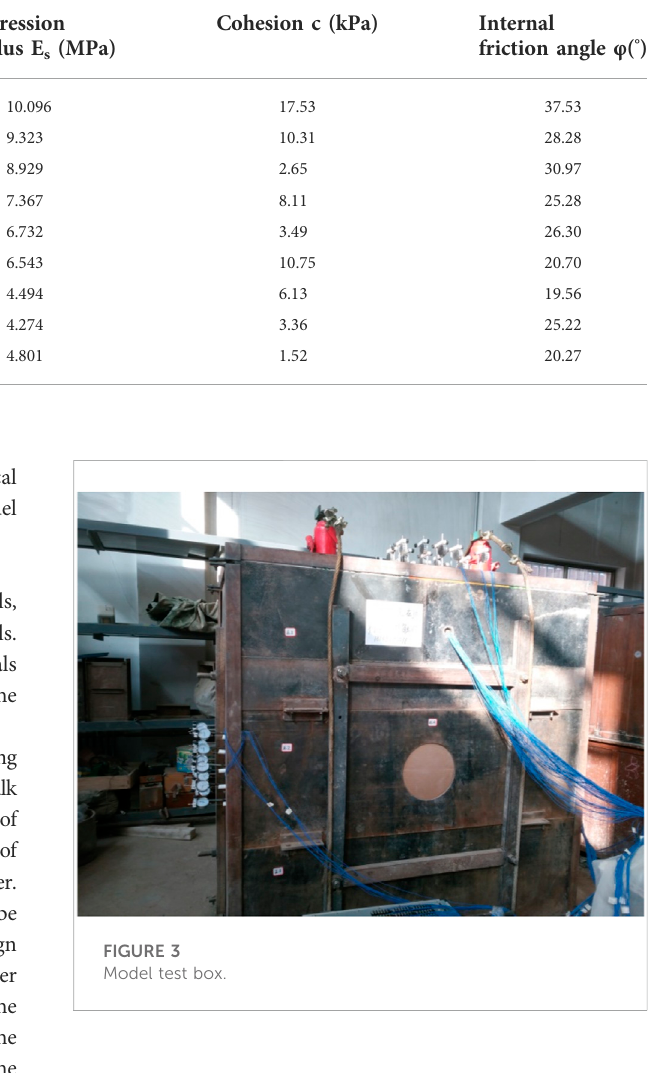
TABLE 3 Physical and mechanical parameters of similar materials with different